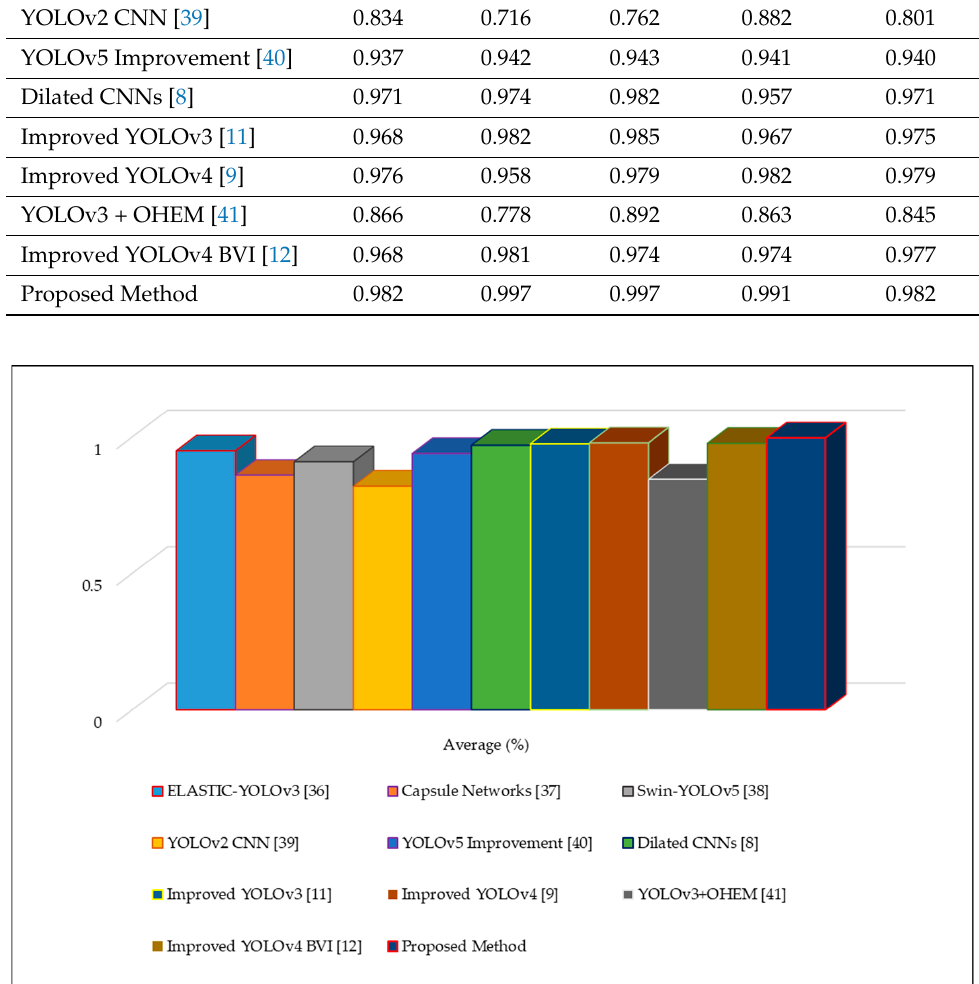
Figure 7. Quantitative results of speech signal feature extraction approaches using vertical graphs.